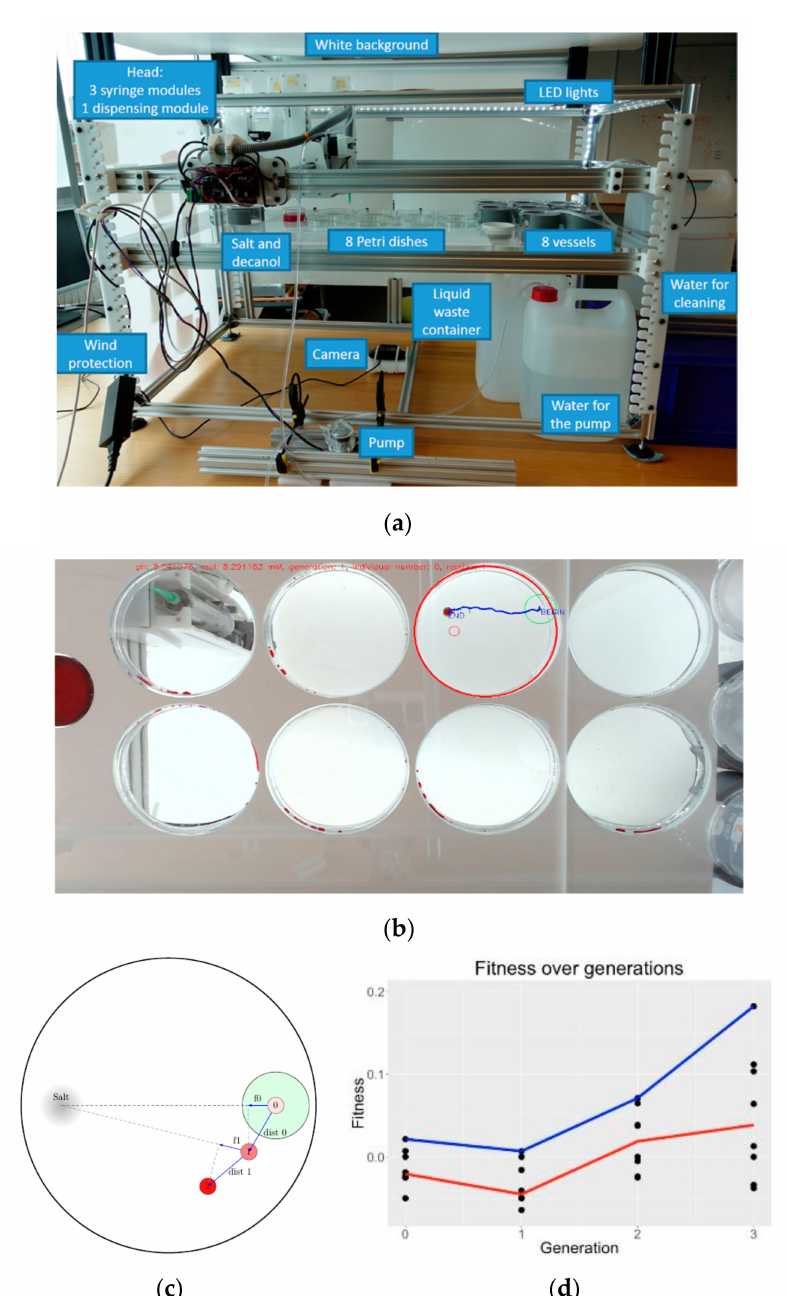
Figure 9. Studying chemotaxis in decanol droplets. ( a ) The setup of the robot with 3 syringe modules, one dispensing module, 8 Petri dishes for experiments, vessels with 1-decanol (with red colour), salt and decanoate at di ff erent pH concentrations. ( b ) The image captured from the camera placed below the experimental layer. At some specific pH and concentrations of decanoate, the salt gradient induces a chemotactic behaviour in the 1-decanol droplet. The path of the droplet is analysed in real time and stored (blue line), and the edge of the Petri dish is detected (red circle). ( c ) Each experiment is scored using a fitness function. The initial position of the droplet for the fitness calculation, when it leaves the safe area (green circle), is the indicated by droplet 0. After eight frames, the droplet has moved to position 1. The vector dist 0 is projected on the axis droplet-salt, and the partial fitness, f0, is calculated. The same procedure is repeated every eight frames. The total fitness is the sum of the partial fitness divided by the number of frames. ( d ) The robot optimized the pH and the concentration of decanoate using an evolutionary algorithm, in order to maximize the chemotaxis of the droplet. The blue and red lines represent respectively the best individual and the median of the population for each